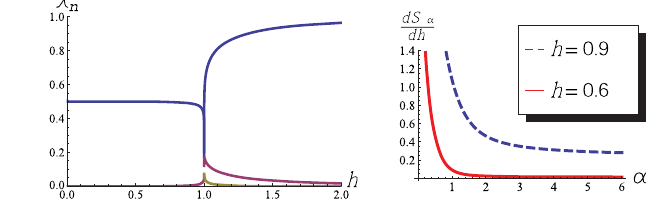
FIG. 2. Plot of the occupation number ν correlation matrix (A6) as a function of h for L ¼ 2 (left) and L ¼ 10 (right). For L ¼ 2 , the explicit form of the eigenvalues ν is given in Eq. (A8). Notice that only one of the ν ’ s exhibits nontrivial behavior: It corresponds to the boundary state, which is only partially contained in the subregion.